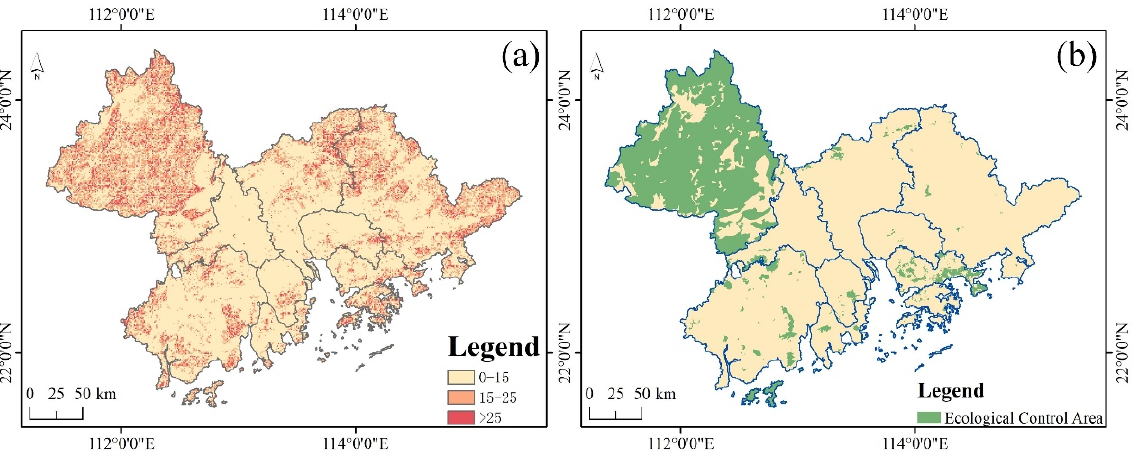
Figure 9. The constraints in the model. ( a ) Slope constraints where a slope greater than 15 degrees cannot be built-up land and a slope greater than 25 degrees can only be forest. ( b ) Ecological control area derived from suitability zones which cannot change in the process of the model.